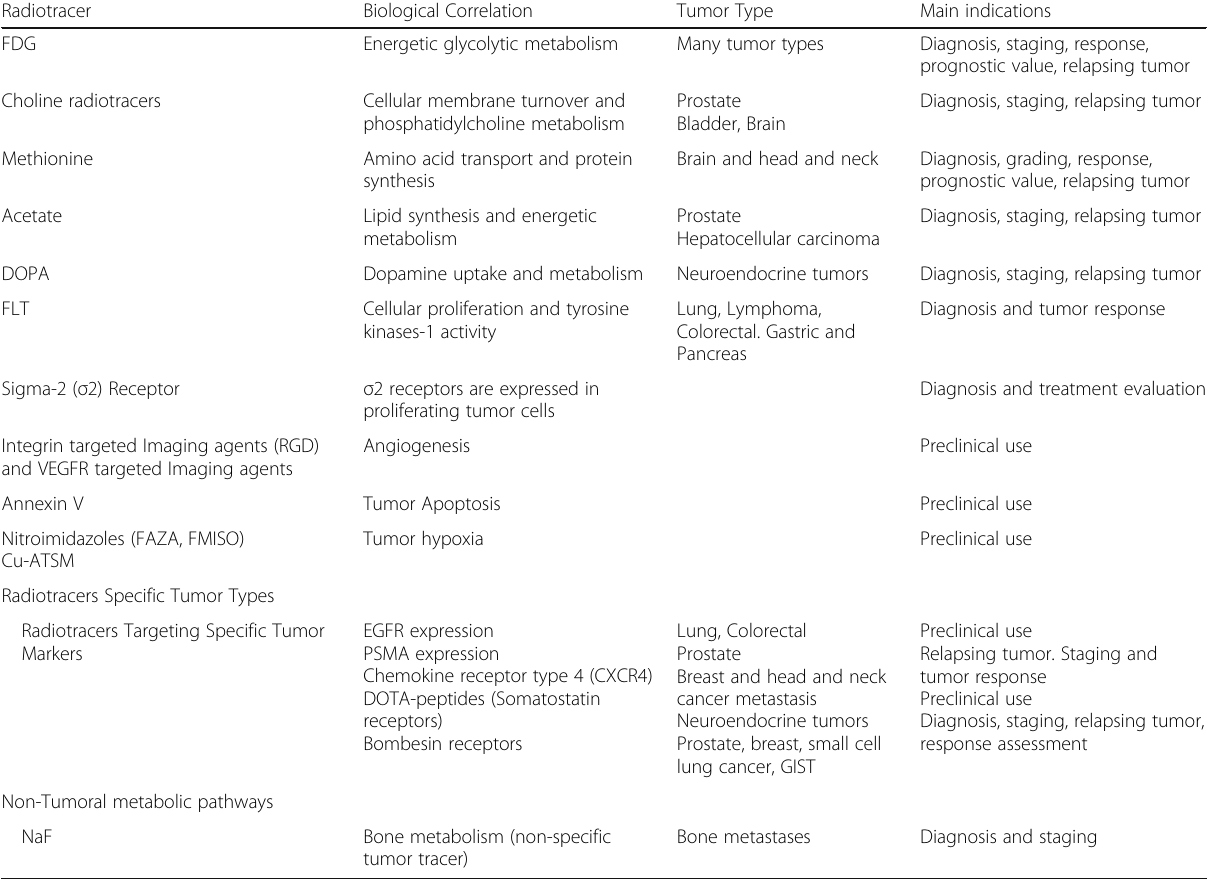
Table 2 Radiotracers in the evaluation of tumor characteristics